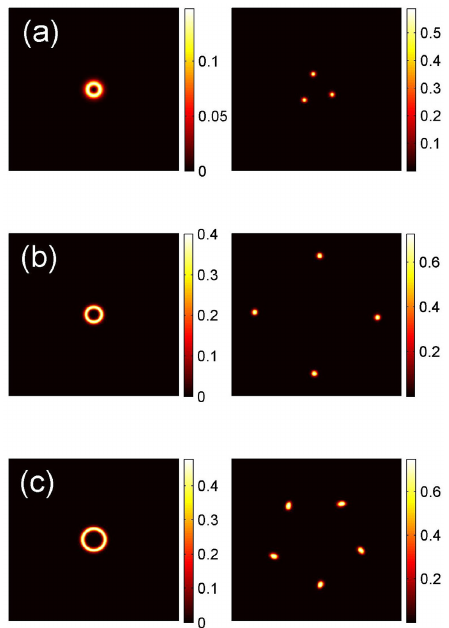
Figure 13. Spontaneous splitting of unstable ring-shaped vortex solitons, with winding numbers s and propagation constants µ , into sets of fragments, as produced by simulations of Equation (40) with α = 1.5: ( a ) ( s , µ = 1, − 0.03 ) ; ( b ) ( 2, − 0.08 ) ; ( c ) ( 3, − 0.095 ) . The left and right panels display, respectively, the local power distribution in the input ( z = 0) and output taken at z = 500. All panels show the domain of the ( x , y ) plane of the size ( − 150, + 1.150 ) × ( − 150, + 1.150 ) . Reprinted with permission from Reference [31]. Copyright 2020